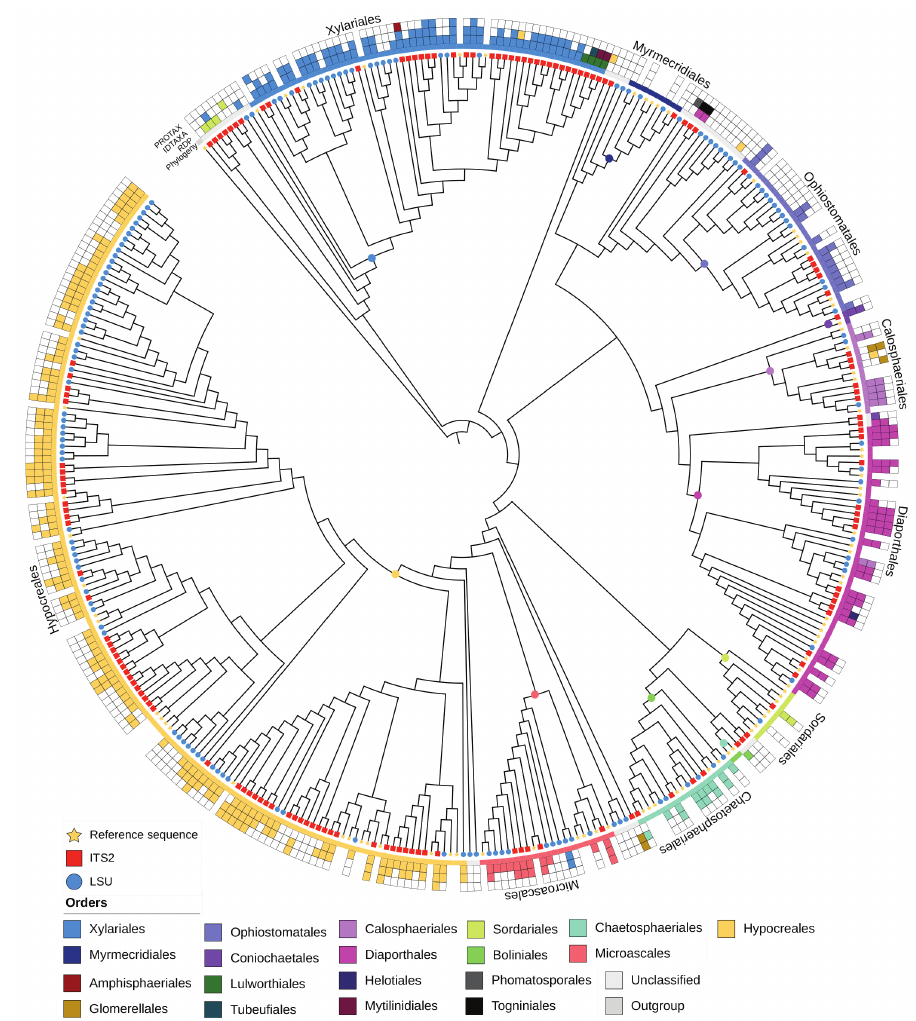
Figure 5. ML tree of Sordariomycetes constructed from the reference sequence alignments and OTUs for both markers (clustering thresholds: 98% ITS2, 99% LSU D1-D2). Leotia lubrica (Leotiomycetes) was specified as the outgroup. The assignment of OTUs by each of the three classifiers (RDP, IDTAXA, Protax-fungi) is shown by coloured boxes. Terminals missing these boxes are the reference sequences. Coloured dots on the nodes of the tree indicate the hypothetical ancestor defining monophyletic groups corresponding to the various orders of Sordariomycetes. The extent of each order is indicated by the coloured inner ring. Note that the ancestor of an order is defined by the youngest node from which all reference sequences are descended; OTUs falling outside of the resulting clades appear as ‘unassigned’ by the phylogenetic analysis approach. The distribution of ITS2 (red squares) and LSU D1-D2 (blue bullets) relative to the reference set (yellow stars) on each of the tips of the tree. Note the limited presence of ITS sequences in the Ophiostomatales (in top right